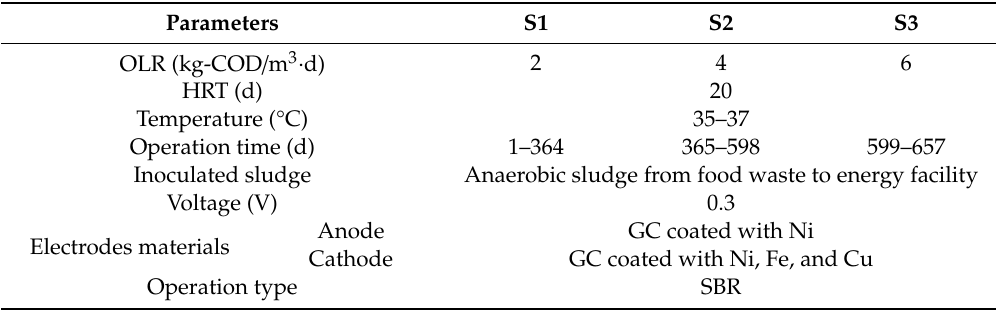
Table 1. The operational parameters of AD and BEAD reactors. OLR: organic loading rate; S: stage; HRT: hydraulic retention time; GC: graphite carbon; Ni: nickel; Fe: iron; Cu: copper; SBR: sequencing batch reactor.